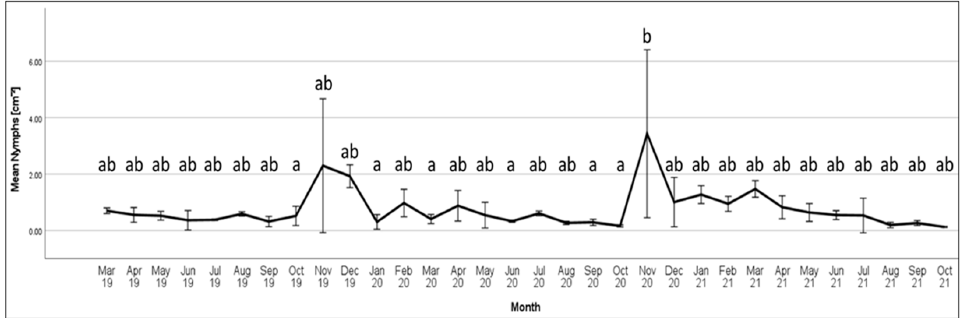
Figure 3. Seasonal mean density of Marchalina hellenica nymphs, combining samples from Pinus radiata at Dalton Reserve and Cardinia Reservoir Park across 32 months (±2 S.E). Significant differences are indicated by groups that do not share a letter (Tukey’s HSD; p < 0.05). N ≥ 2 for March–July